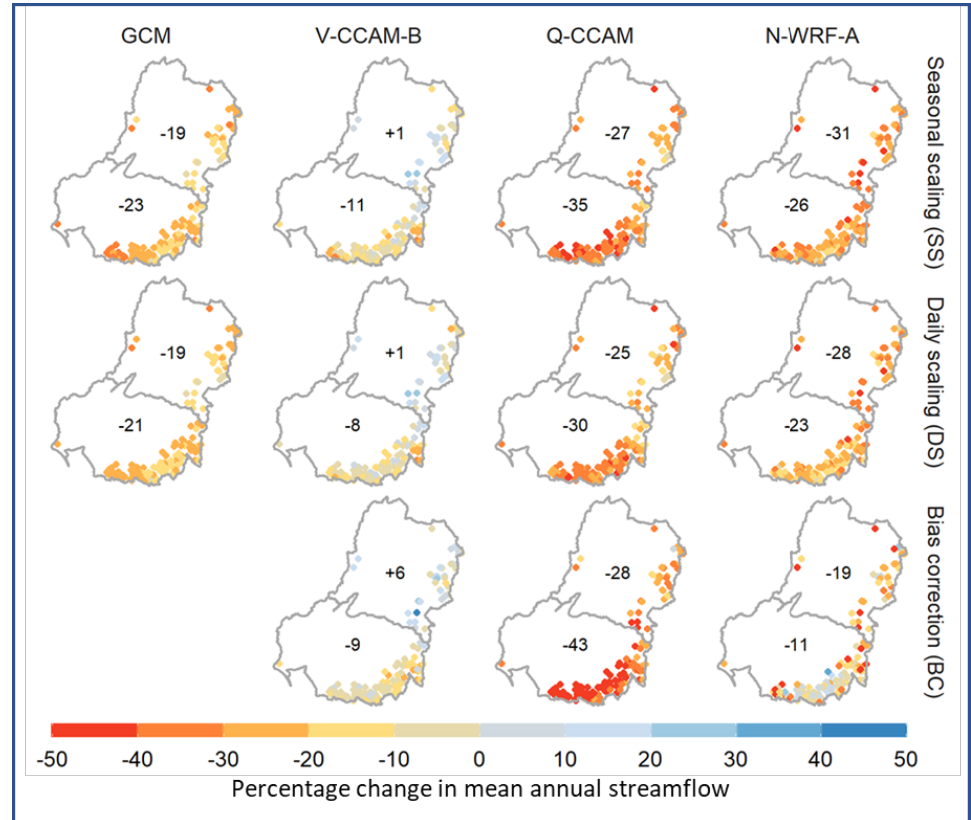
Figure 3. Median value of modelled change in future mean annual streamflow across the 133 catch- ments from each of the different climate projection products and methods used to generate future daily rainfall series (numbers in the map show the average of the median values in all the catchments in the northern MDB and the southern MBD).